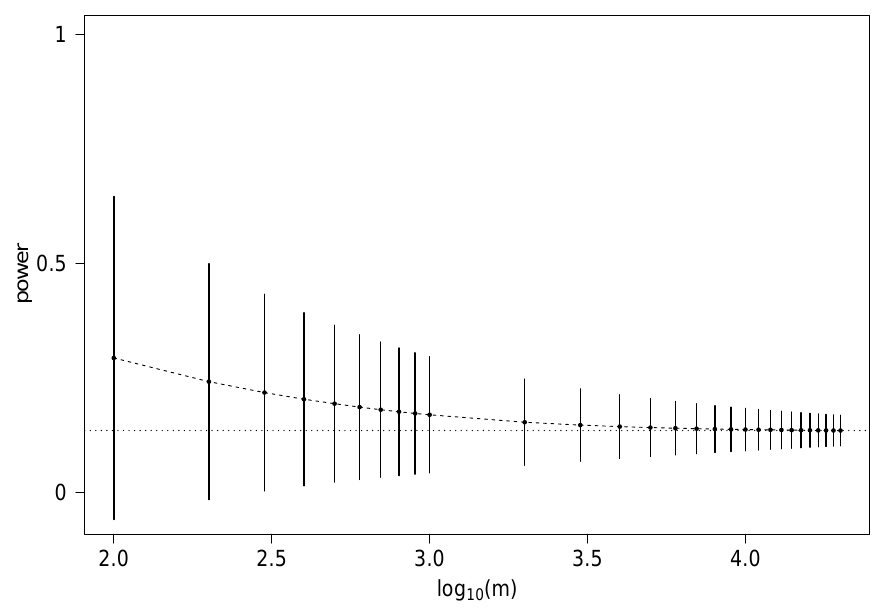
Figure 1. Empirical results when the p -values under the alternative hypothesis have B ( 0.5,100 ) distribution and the proportion of alternative tests is 2%. The x -axis shows the common logarithm of the number of tests m . The y -axis shows the empirical power. The dots depict the mean of the empirical power, the vertical lines are of length one standard deviation below and above the mean. The dotted line shows the asymptotic